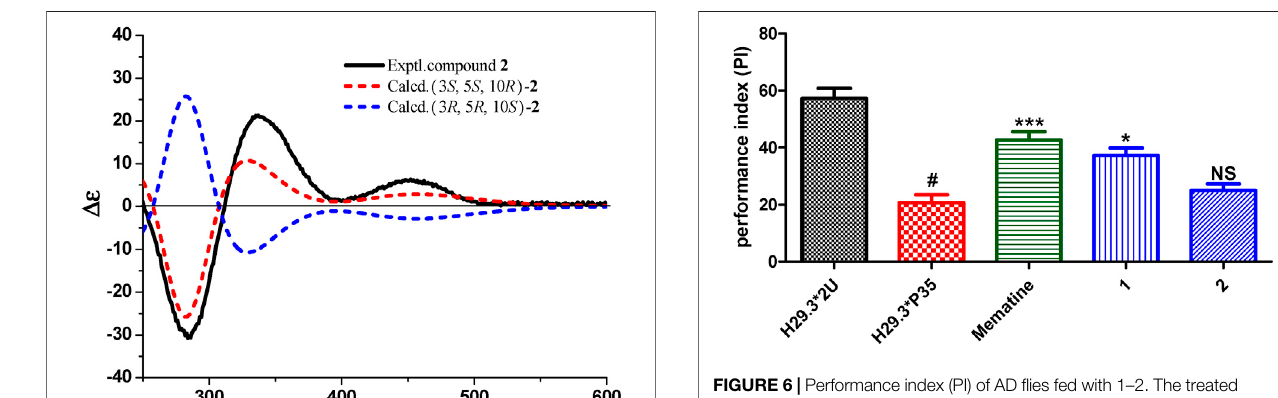
FIGURE 6 | Performance index (PI) of AD fl ies fed with 1 – 2. The treated groupswereAD fl iestreatedwithmemantineortestedcompounds(100 µM), and thecontrolgroups (H29.3*2U representsthenormal fl ies,andH29.3*P35 represents the Ad fl ies were treated with corresponding volume of DMSO. Statistical analysis results of 1 – 2. Each value was expressed as means ± SEM, n (cid:1) 8; # p < 0.001, signi fi cantly different from the AD group, * p < 0.005, signi fi cantly different from the AD group, and NS, no signi fi cantly different from the AD group; one way